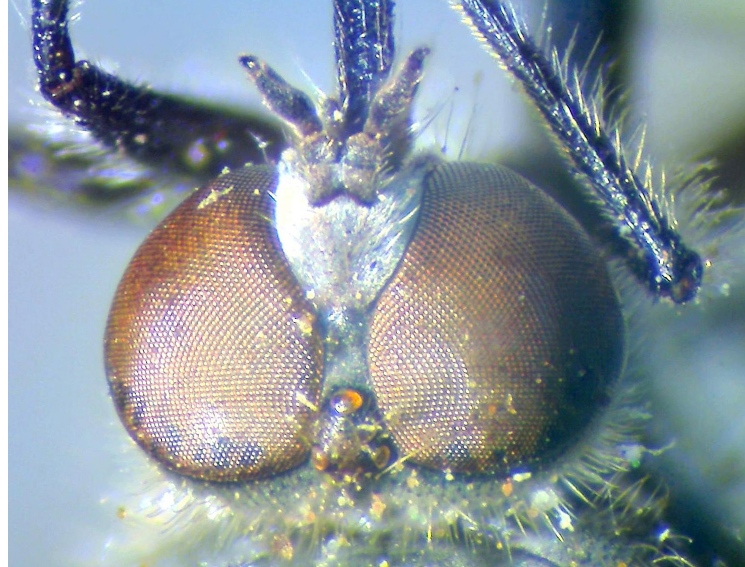
Fig. 19. Parusia benoisti gen. et sp. nov., ♂.